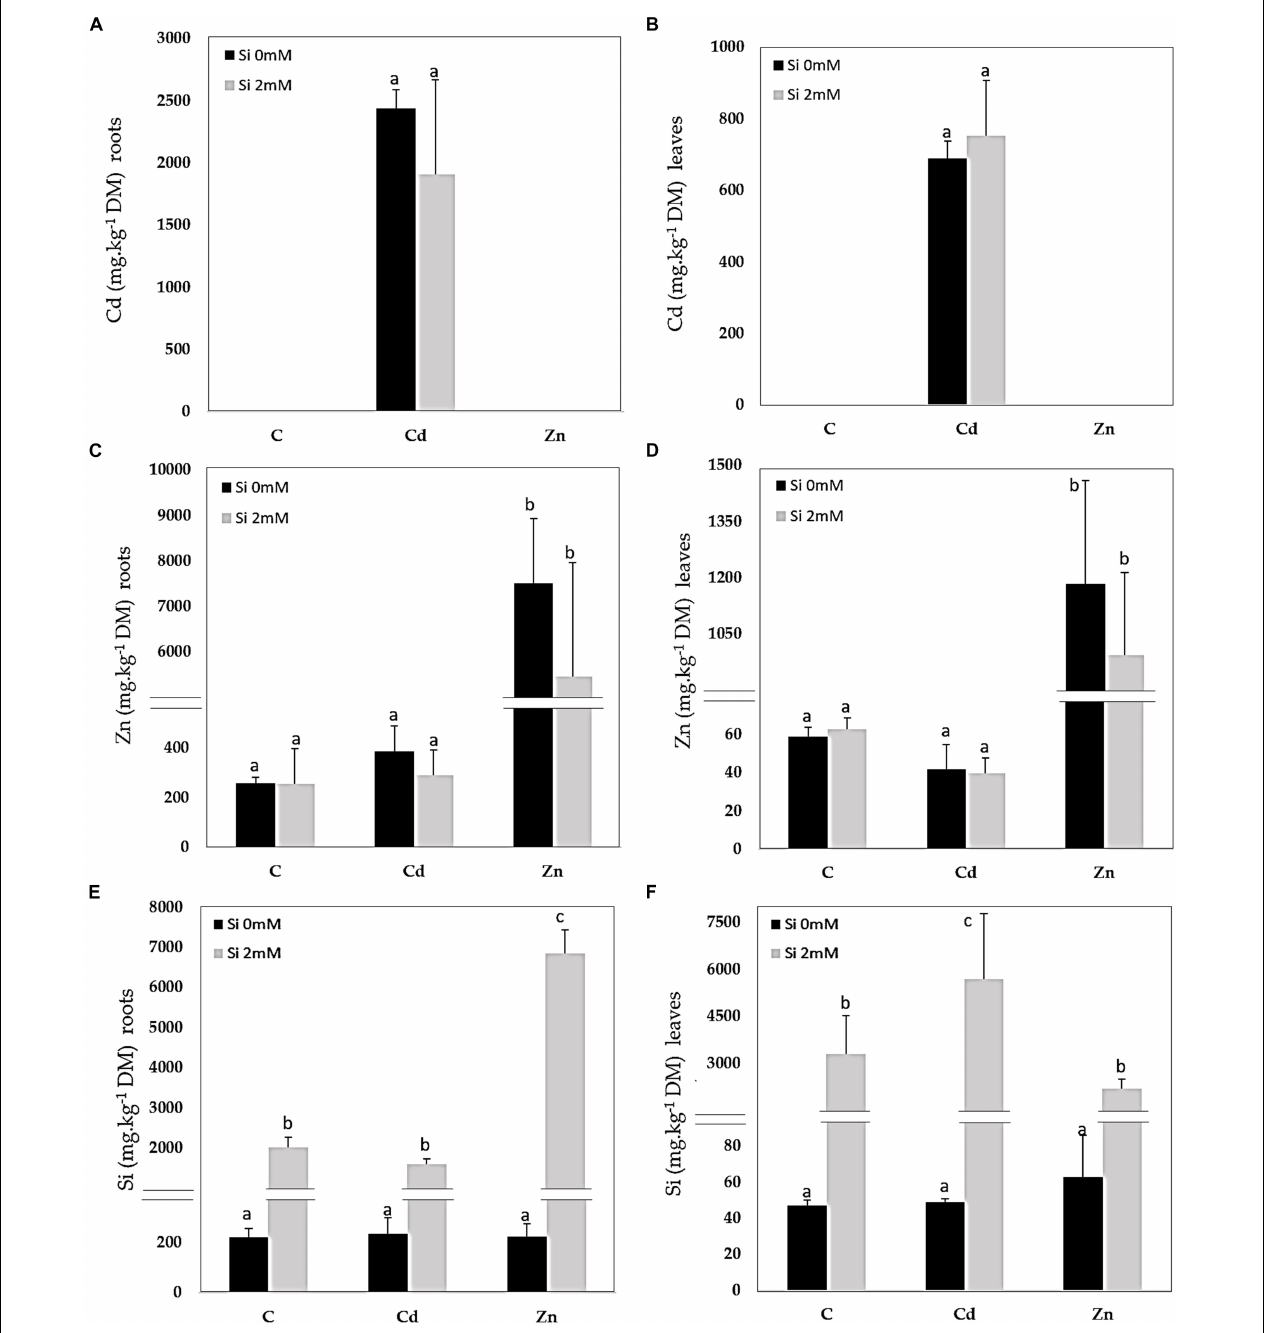
FIGURE 1 | Cadmium (Cd), zinc (Zn), and silicon (Si) in roots (A,C,E) and leaves (B,D,F) of Cannabis sativa (cv. Santhica 27). Plants were exposed for 1 week to Cd (20 µ M) or Zn (100 µ M) in the presence or absence of Si (2 mM) [C: control plants not exposed to heavy metals (HM)]. The different letters indicate that the values are significantly different from each other [ p < 0.05; Tukey’s honestly significant difference (HSD) all-pairwise comparisons].